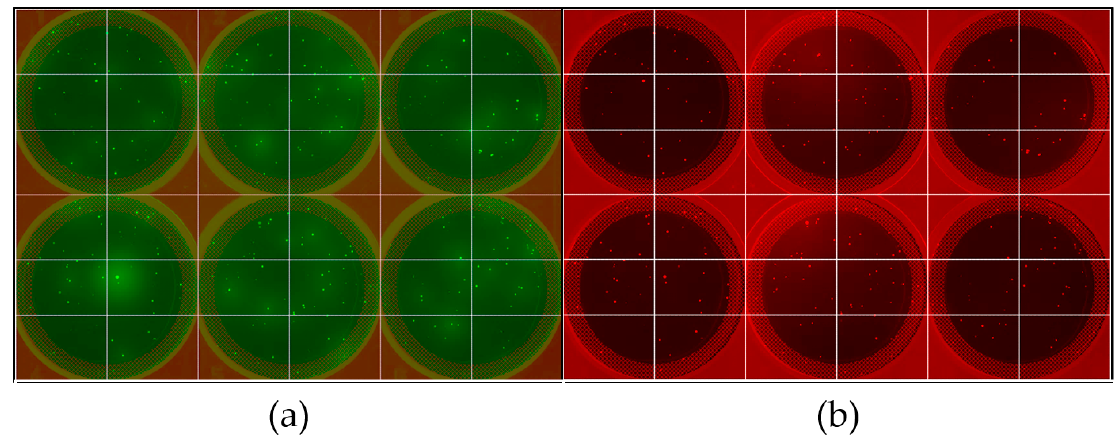
Figure 1. Fluorescence imaging by ClonePix 2 of unbiased combinatorial linear peptide library on HMBA-ChemMatrix resin after incubation with fluorescently tagged immunoglobulin G (IgG) and CHO-S host cell proteins (HCP). ( a ) Library is imaged with a ClonePix 2 FITC filter to visualize beads bound to IgG tagged with Alexa Fluor 488. ( b ) The same plate is imaged with a ClonePix 2 Rhodamine filter to visualize beads bound to CHO HCP tagged with Alexa Fluor 546.